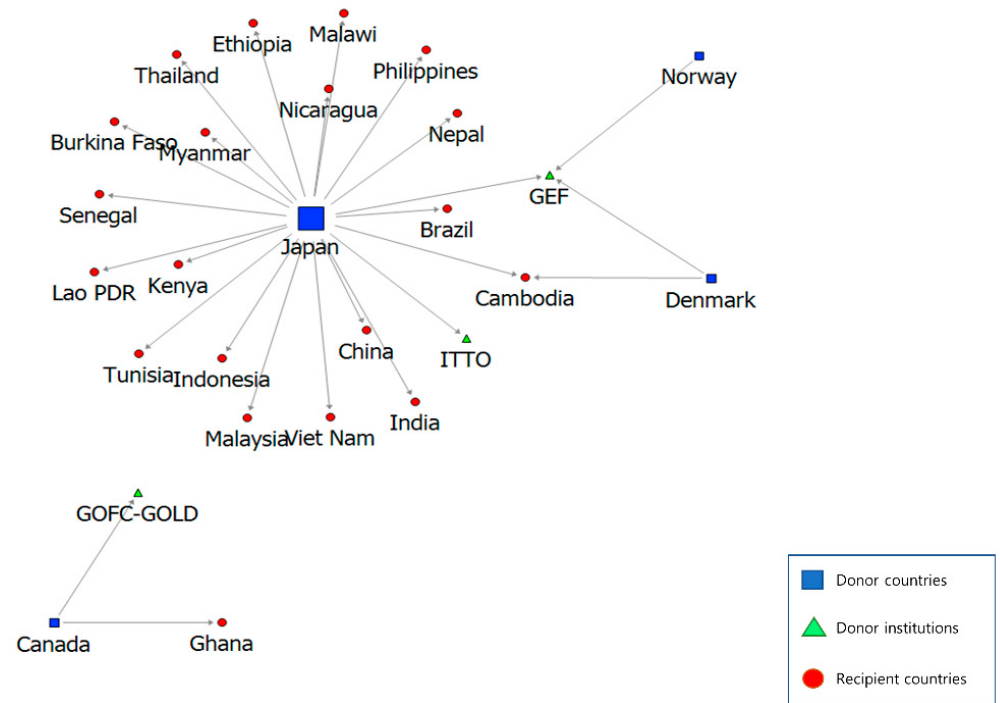
+ financial network in